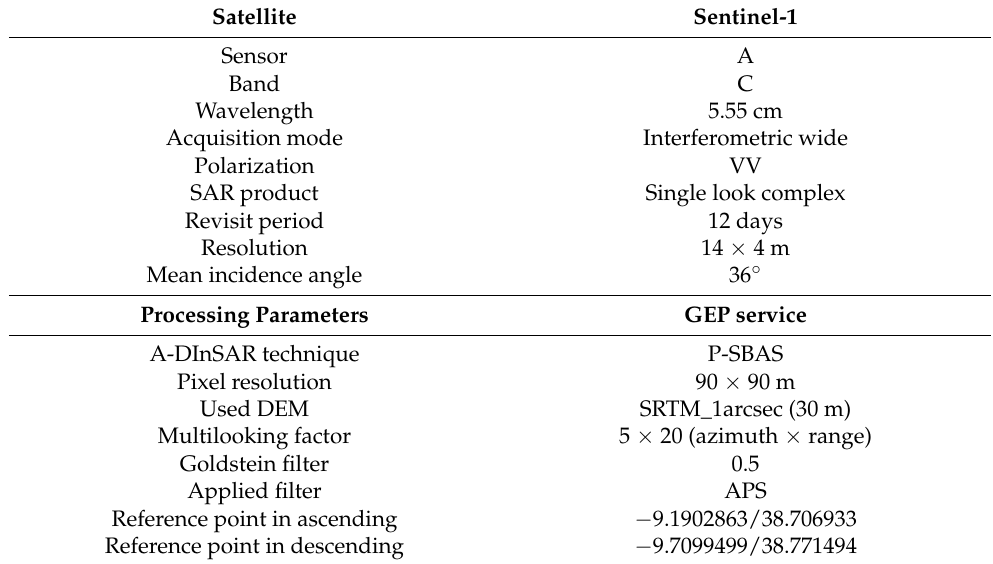
Table 1. Main acquisition parameters of the SAR satellite used dataset and principal processing parameters of P-SBAS chain of the GEP. See location of reference points in Figure